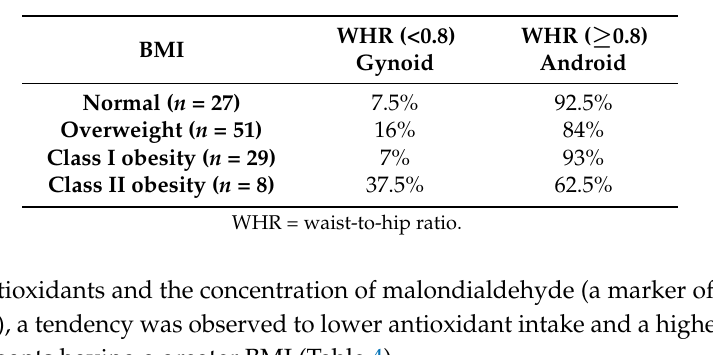
Table 3. Percentage of patients with gynoid or android fat distribution, classified by body mass index